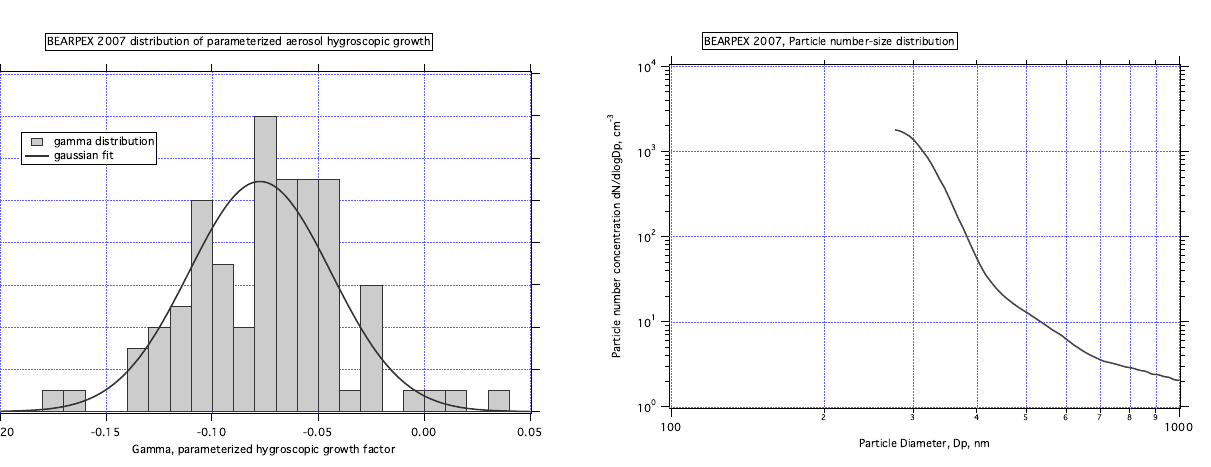
Fig. 3. Measured aerosol hygroscopic growth parameter, plotted as the exponent ( − γ ) in Eq. (1), during BEARPEX 2007. The plot shows frequency of occurrence and a Gaussian fit to the distribution.